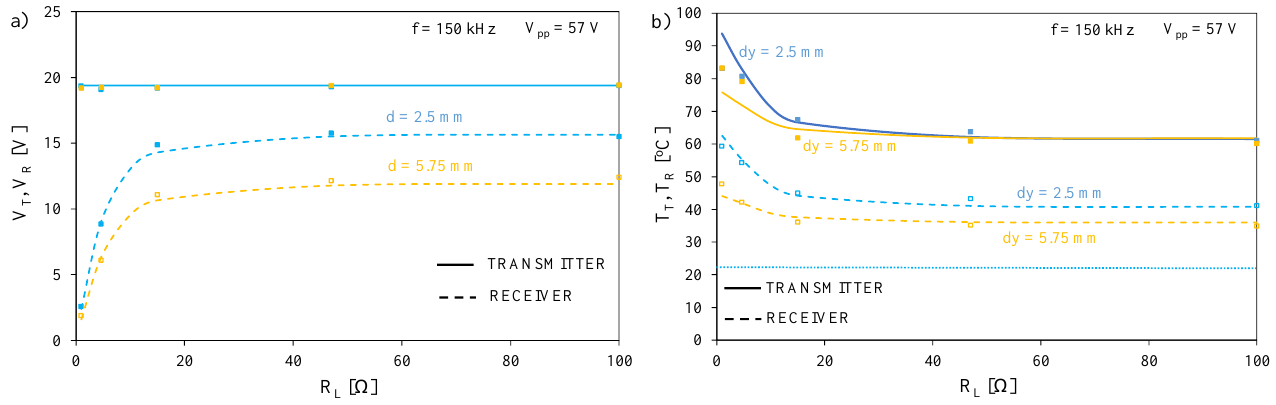
Figure 11. Dependence of voltages on the transmitting and receiving coils ( a ) and their temperatures ( b ) on load resistance at two values of distance dy between these coils.